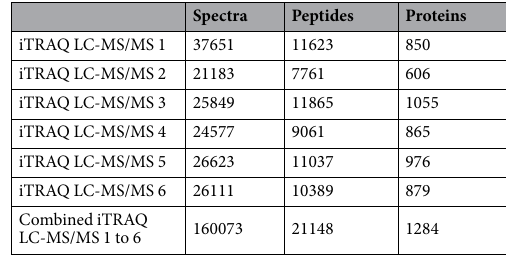
Table 3. PSPEP Protein Summary Report for Proteins Identified at ≤ 1% Global False Discovery Rate. LC, liquid chromatography; MS, mass